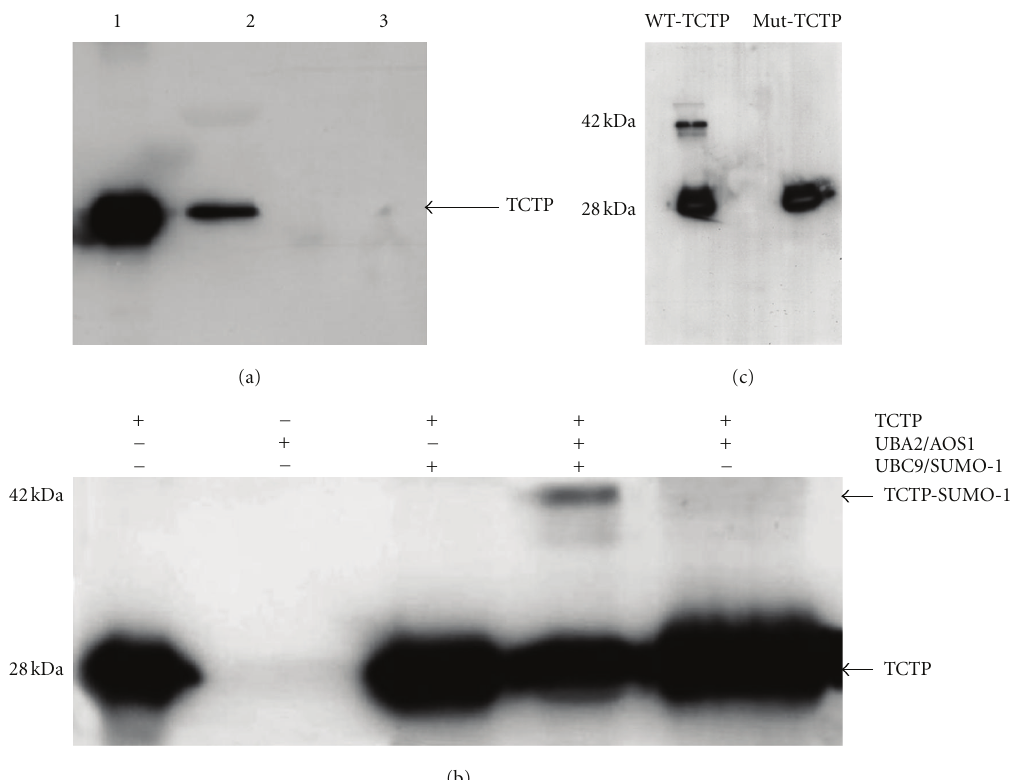
Figure 1: TCTP can be sumoylated in vitro . GST Pull-Down assay (a). Proteins were resolved on a 12% SDS-PAGE and transferred to a nitrocellulose membrane and probed with anti-HIS antibody. Lane 1:5 µ g of rTCTP, Lane 2, shows the amount of TCTP that bound to the GST-Ubc9 enzyme, and Lane 3 shows the amount of TCTP that bound to GST alone control. These results show that TCTP strongly binds to Ubc9 enzyme. In vitro sumoylation assay (b) . Proteins were resolved on 12% SDS-PAGE and transferred to nitrocellulose membrane and probed with anti-His or anti-TCTP antibody to detect TCTP. Note the high molecular weight product (TCTP-SUMO-1) in Lane 4, where the incubation mixture contained TCTP, UBA2/AOS1, and Ubc9/SUMO. Deletion of any one of these products from the reaction mixture resulted in the absence of this high molecular weight band (Lanes 1, 2, 3, and 5). Mutation studies (c), The lysine residue (aa 164) in the TCTP was mutated to arginine. When such mutated TCTP was subjected to in vitro sumoylation, SUMO-1 failed to bind to mutated TCTP, whereas wild-type TCTP could be sumoylated under the same